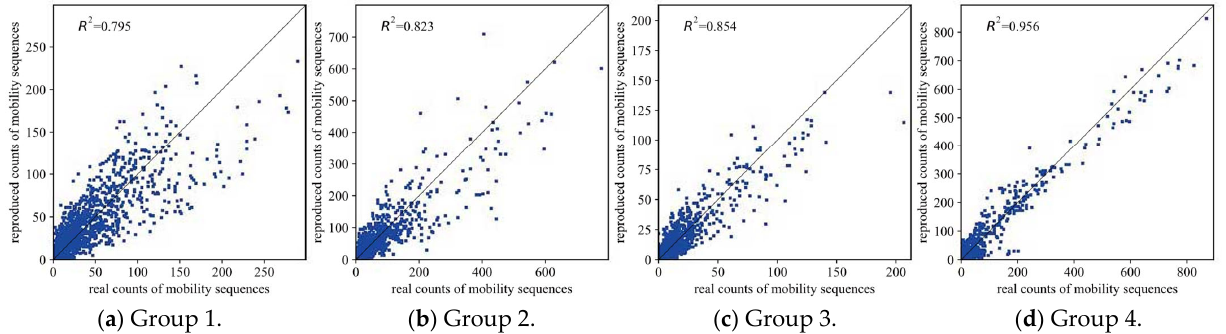
Figure A5. Spatiotemporal evaluation for each group for 1988. ( a ) Evaluation for Group 1; ( b ) Eval ‐ uation for Group 2; ( c ) Evaluation for Group 3; ( d ) Evaluation for Group 4.